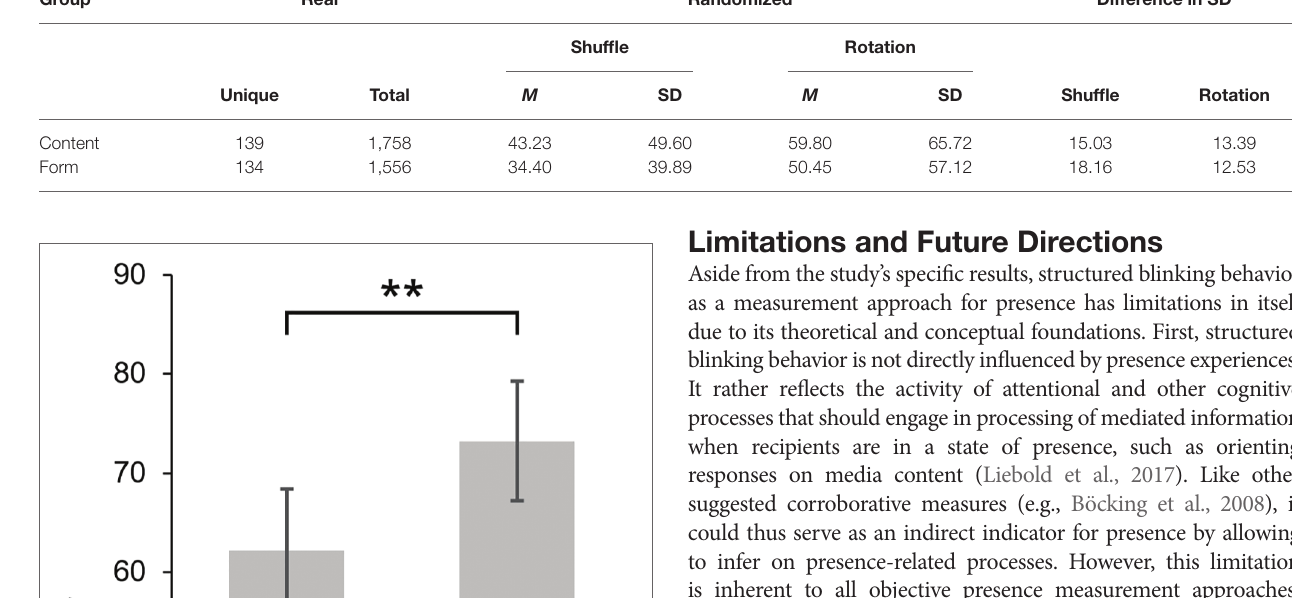
TABLE 2 | T-patterns with blinks as viewer behavior and cinematic structure as media events in real data and randomized data. Group